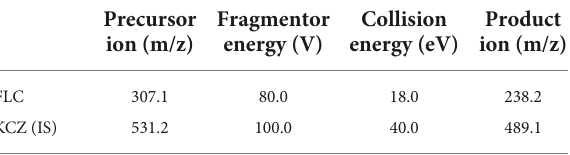
TABLE 1 Optimized MRM (multiple reaction monitoring) parameters for FLC and